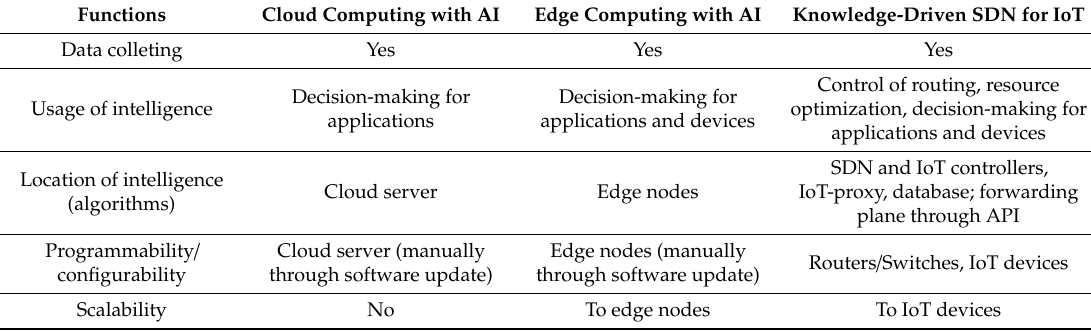
Table 5. Di ff erence between cloud, edge computing and knowledge-drive SDN for IoT.